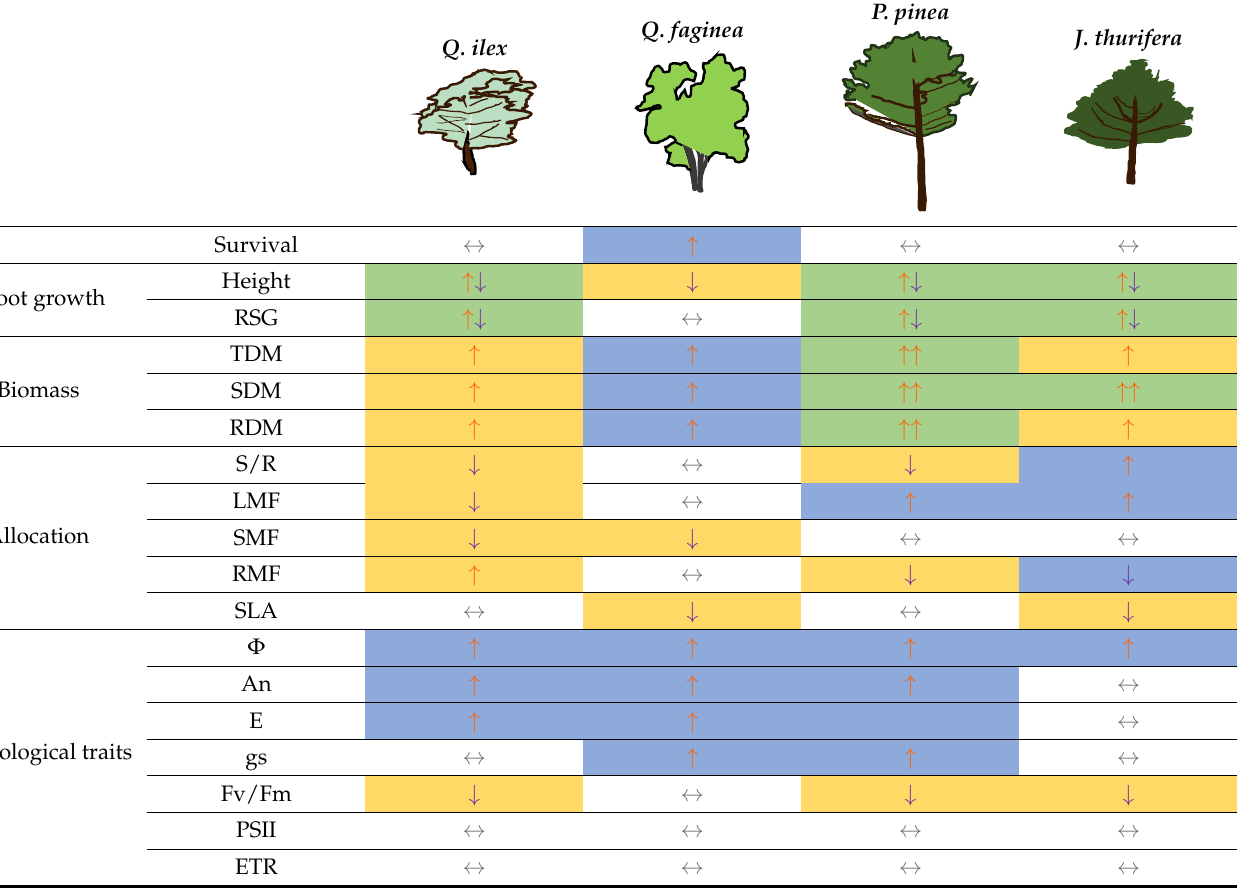
Table 2. Schematic representation of the main significant effects of treatments (water availability (W) in blue, light (L) in yellow, water availability and light (W,L) in green, no effect in white) on the different traits studied on the four species, at the end of the experiment.